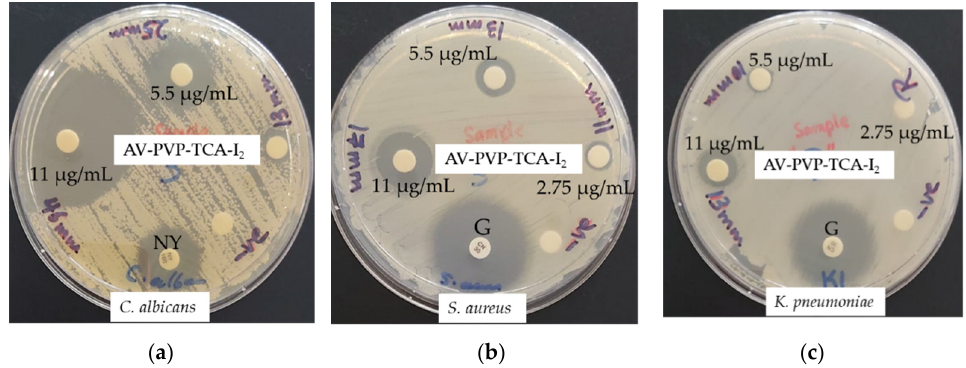
Figure 9. Disc diffusion assay of AV-PVP-TCA-I 2 (with concentrations of 11, 5.5 and 2.75 µg/mL) with positive control antibiotic nystatin (NY = 100 IU) and gentamicin (G = 30 µg/disc). From left to right: AV-PVP-TCA-I 2 against ( a ) C. albicans WDCM 00054; ( b ) S. aureus ATCC 25932; ( c ) K. pneumoniae WDCM 00097.